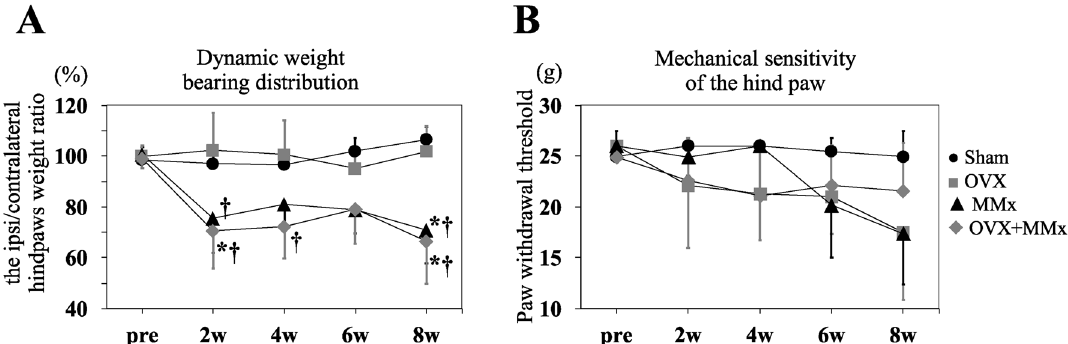
Figure 5. Pain-related behavioural tests. The pain-related behaviours were assessed using the dynamic weight bearing test ( A ) and von Frey test ( B ). Lines represent the mean and 95% CIs. *: p < 0.05 compared with the Sham group; †: p < 0.05 compared with the OVX